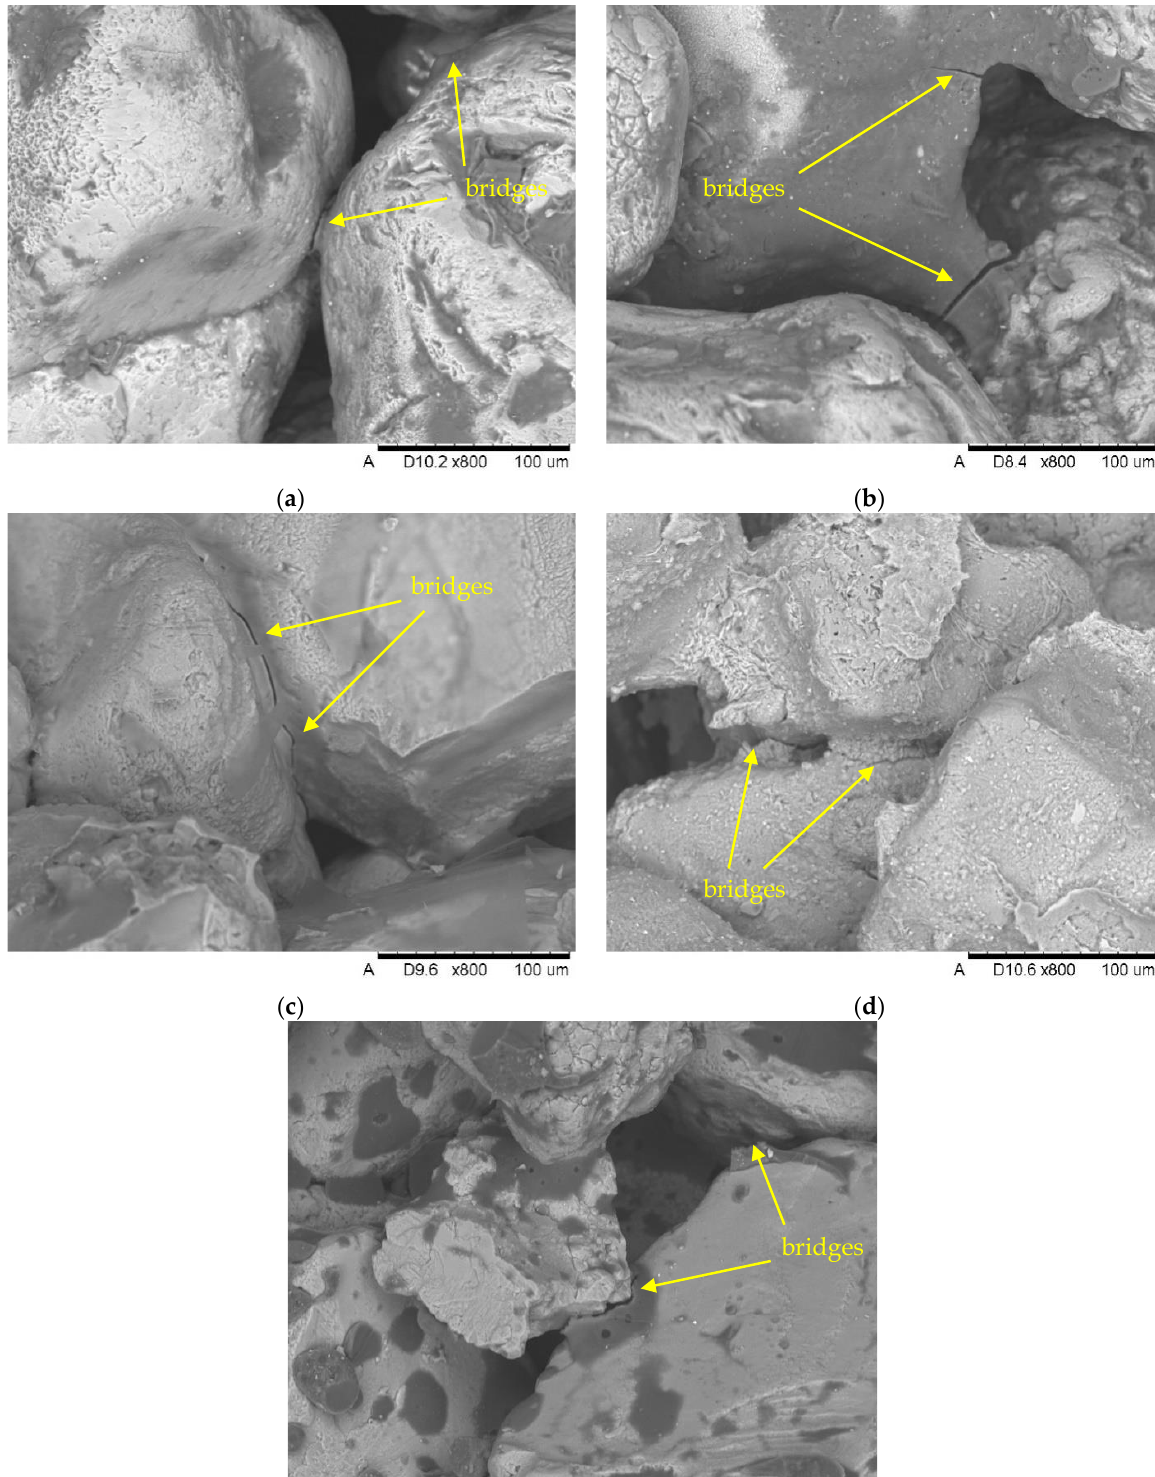
Figure 6. Destruction of bonding bridges after testing the bending strength of masses containing binders (SE imaging technique): ( a ) MB 2%, ( b ) MB 5%, ( c ) WG, ( d ) B 8%, ( e ) RSC. Masses based on barley malt (Figure 6a,b) and a water glass (Figure 6c) are charac- terized by the destruction of the cohesive type, i.e., the system in which the adhesive